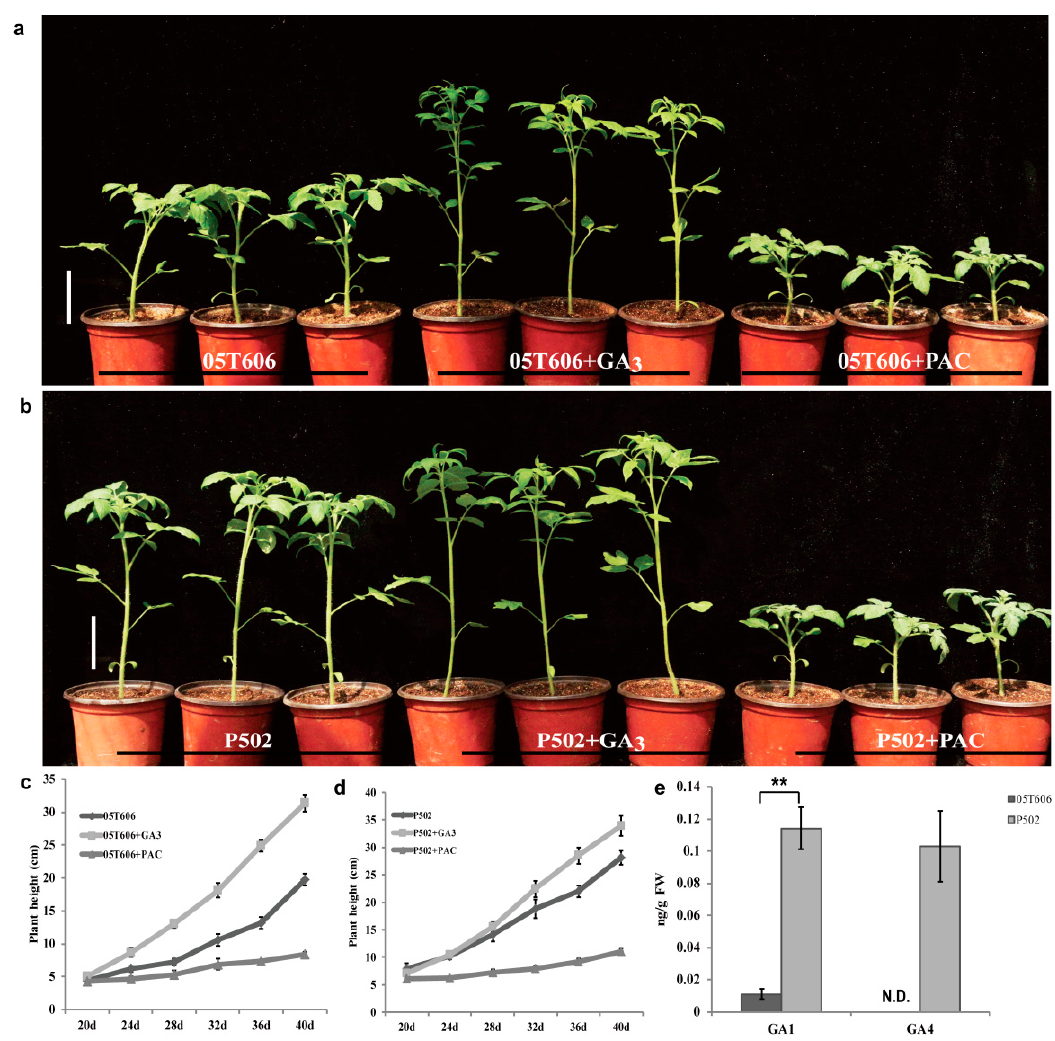
Figure 2. The line P502 is a GA-sensitive mutant. ( a ) and ( b ) The morphological phenotypes of 30-day-old wild-type and P502 seedlings after treatment with GA 3 (10 − 5 M) and PAC (10 − 7 M, GA biosynthesis inhibitor), respectively. ( c ) and ( d ) The statistical data of wild-type and P502 plant height in different stages, respectively. ( e ) Concentration of endogenous bioactive GAs in the first five internodes of 30-day-old mutant P502 and wild-type seedlings. The water treatment was used as control and the scale bar is 5 cm in ( a ) and ( b ). Data for ( c ) and ( d ) are based on three replicates of eight plants per group. N.D. represents not detectable. Data for ( e ) are based on three independent biological replicates, and the asterisk indicates a statistically significant difference (Student’s t -test, ** p < 0.01). All data are given as mean ± SD.